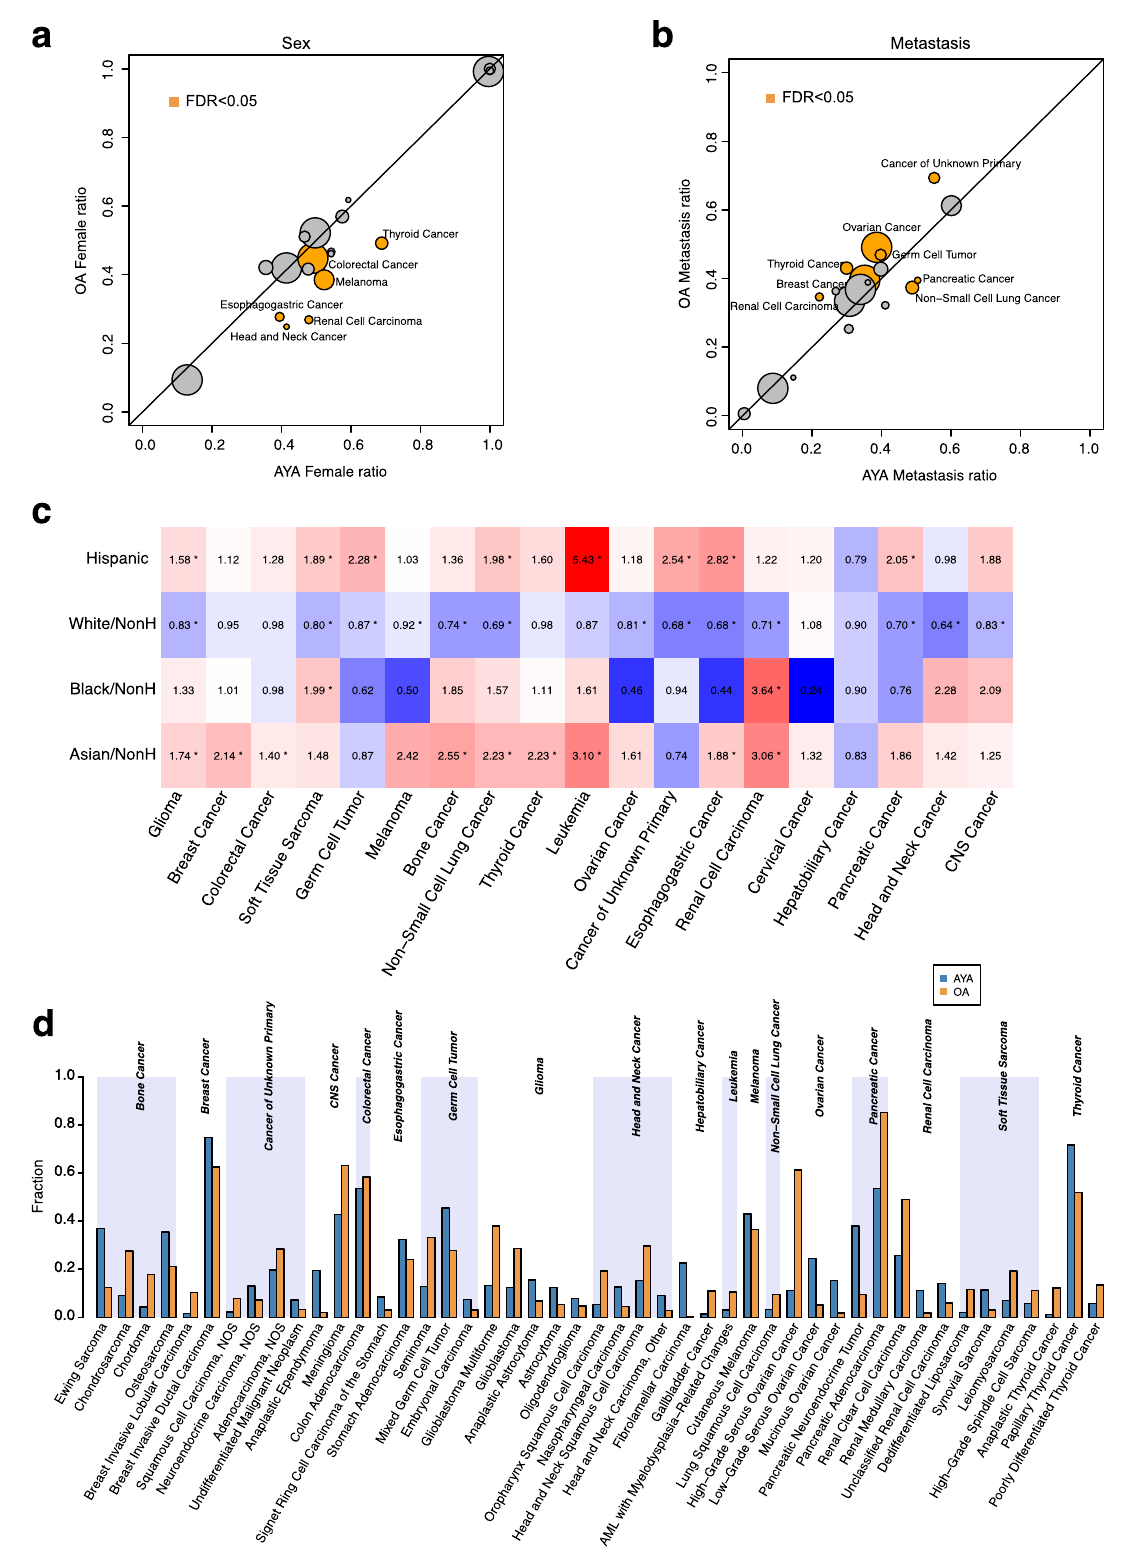
Fig. 1 | Clinical disparity between AYAs and OAs. a Female fraction, ( b ) and metastasisfractionbetweenAYAandOAin19tumortypes.Circlesizecorresponds to AYA sample counts of the speci fi c tumor types. Orange color indicates statisti- cally signi fi cant differences (FDR<0.05). Cancer types were labeled for those with signi fi cant differences (FDR<0.05). c Comparison of race and ethnicity between